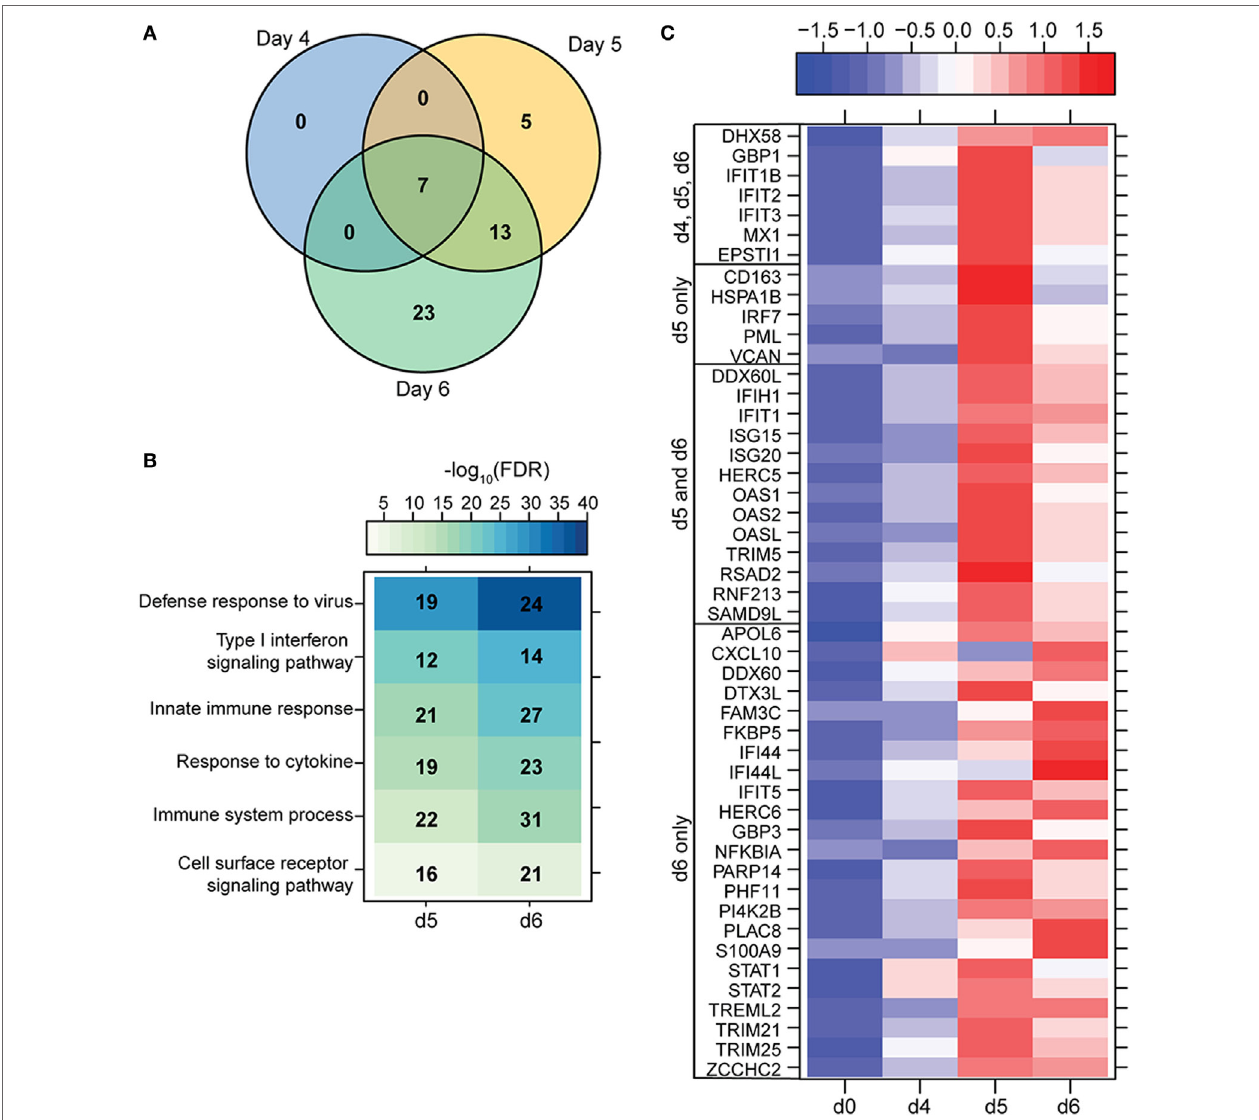
FigUre 4 | ZEBOV-Makona infection induces limited differential gene expression in T-cells. (a) 3 way Venn diagram displaying overlap between differentially expressed genes (DEGs) detected 4, 5, and 6 DPI. (B) Heatmap representing functional enrichment of DEGs 5 and 6 DPI; color intensity represents the statistical significance (shown as negative log 10 of the false discovery rate (FDR)-corrected p -value); range of colors is based on the lowest and highest –log 10 (FDR) values for the entire set of terms; the number of DEGs mapping to each Gene Ontology term each day is listed within each box. (c) Heatmap representing gene expression (shown as absolute normalized RPKM values) of all DEGs detected 4, 5, and 6 DPI; range of colors is based on scaled and centered RPKM values of the entire set of genes (red represents increased expression while blue represents decreased expression); each column represents the median RPKM values for each